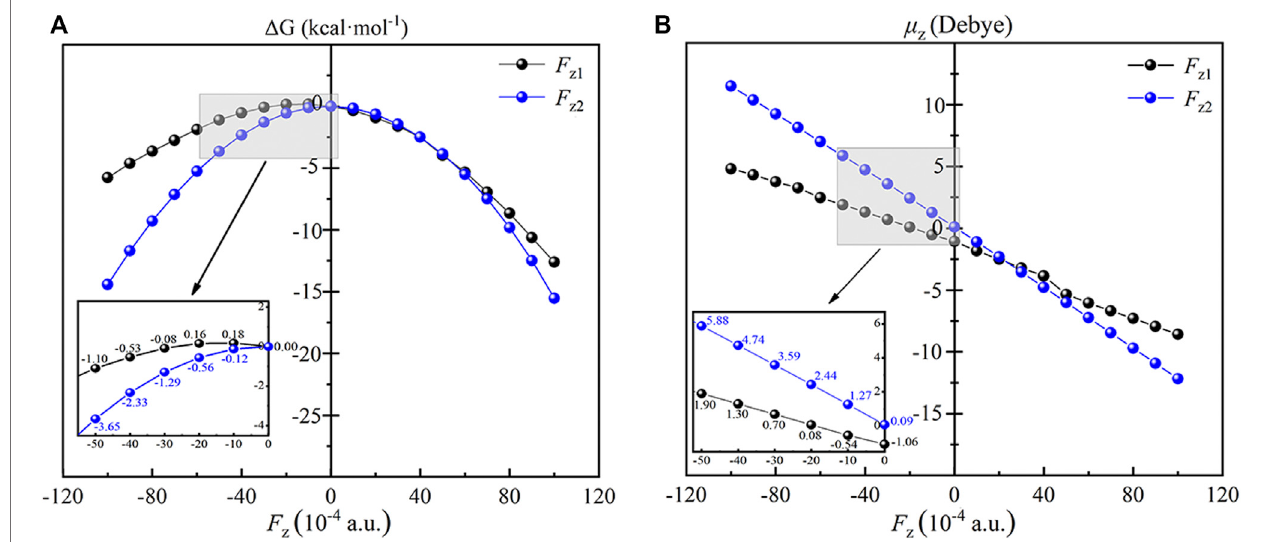
FIGURE5| Plotsoftherelativeenergies (A) andthedipolemoments (B) oftheTS1asafunctionoftheappliedOEEFs.Theinsetistheenlargedviewat F z1 and F z2 = − 0.005 a.u. to 0 a.u. black curve for F z1 and blue curve for F z2 .